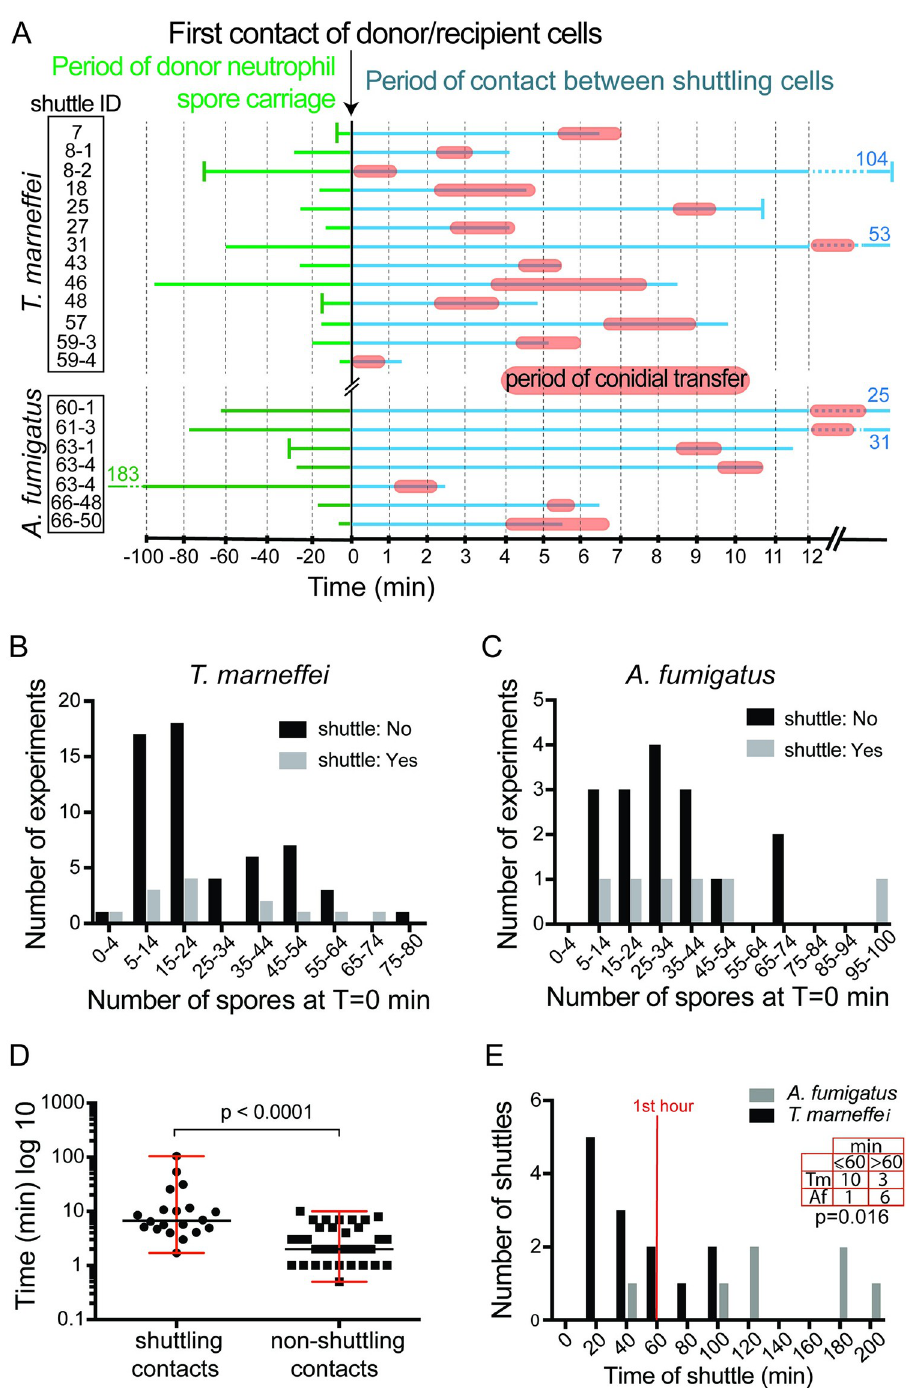
Fig 5. Dynamics of neutrophil-to-macrophage conidial shuttles. (A) Time maps of cellular contact during shuttles. Charts are aligned with t = 0 at the point of initial donor–recipient cell contact. Chart shows time of conidial residence in donor neutrophil prior to intercellular contact (green line; vertical bar indicates resident at start of imaging; otherwise, line start indicates point of neutrophil phagocytosis), time of general intercellular contact (blue line), and period of contact during actual conidial transfer (orange bars). Charts are for each of 20 stringently defined unequivocal shuttles ( n = 13 T . marneffei , n = 7 A . fumigatus ) tabulated and identified as in S1 Fig. The entire sequence from phagocytosis to cell separation is shown unless vertical bars at beginning or end of lines indicate the start or end of the imaging file; blue and green numbers indicate endpoint times where lines have been clipped. (B,C) For T